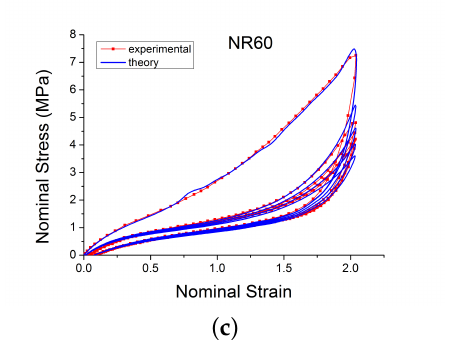
Figure 8. Comparison of the new model with experimental data loaded with cyclic uniaxial test with uniform maximum strain amplitude [14]. Subfigures ( a – c ) show respectively the behaviour for NR2, NR40 and NR60.